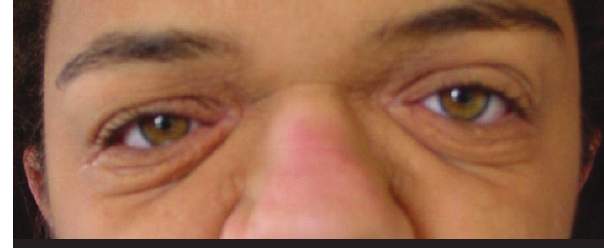
Figure 1 - Preoperative view showing a cutaneous excess on the lower eyelid before resection of the upper eyelid skin and lateral canthal suspension